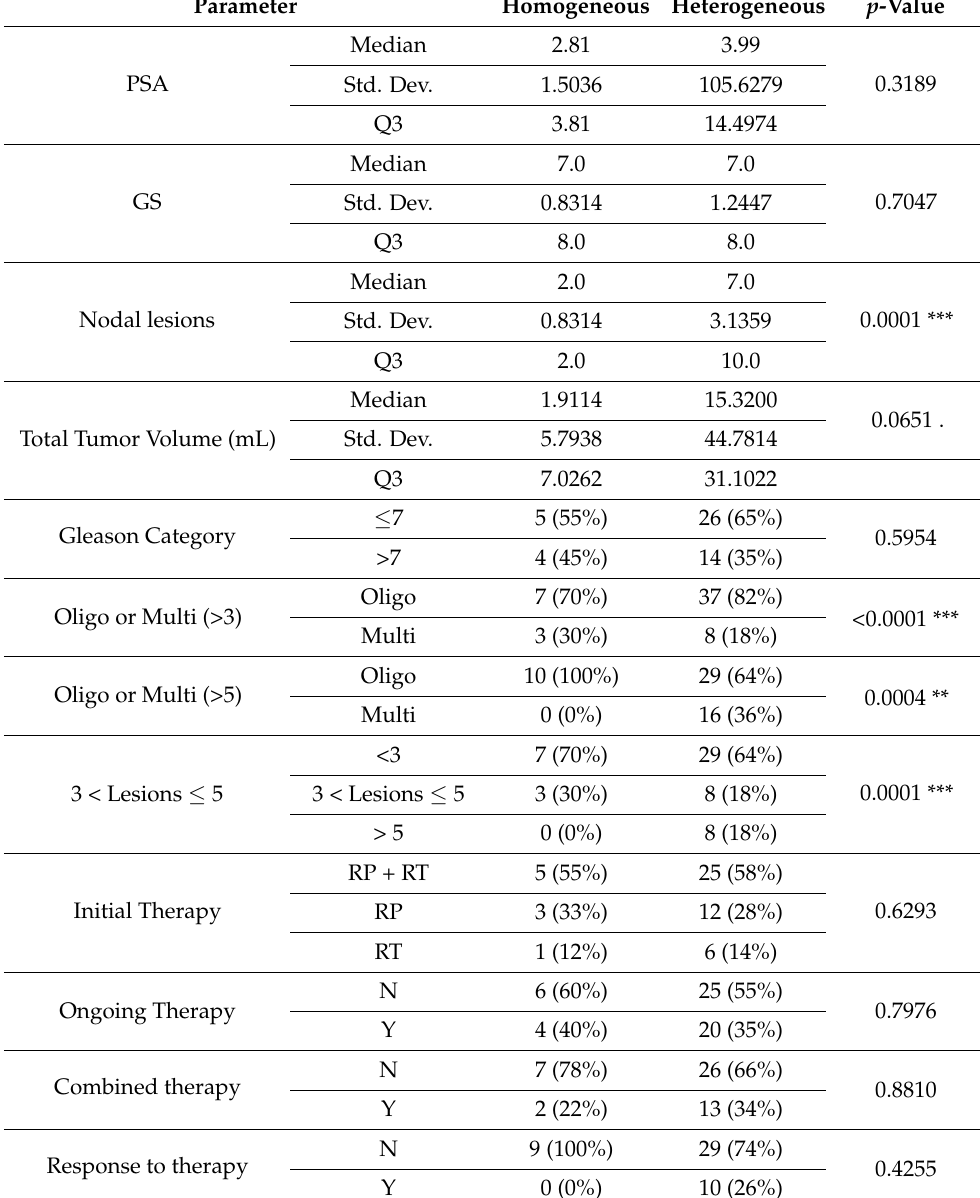
Table 3. Tests on PSA, GS, oligo/multi-metastatic status, number of lesions, type, and response to therapy highlighted differences among the two patients’ phenotypes, i.e., homogeneous and heterogeneous ( p